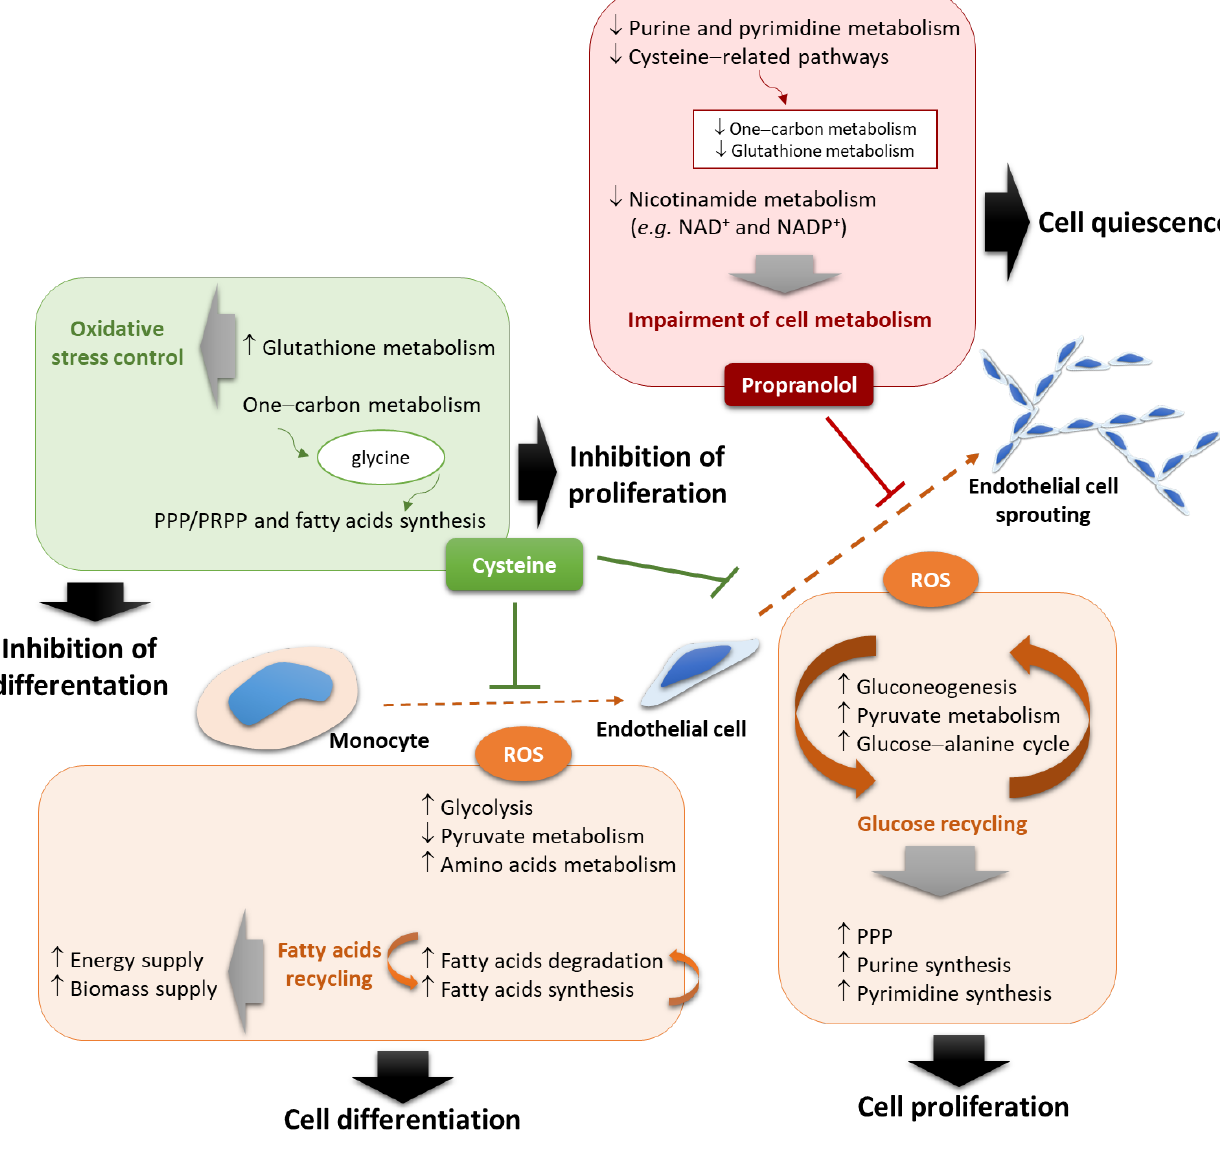
Figure 7. Metabolic profiling is an indicative of cell biological processes. ROS are a main stimulus for monocyte-to-endothelial-cell differentiation and endothelial cell proliferation. In this differentiation process, monocytes present increased glycolysis and amino acid metabolism with decreased pyruvate metabolism and fatty acid recycling. The ROS-dependent activation of proliferation is accompanied by a glucose-recycling metabolic adjustment, which will favor glucose-dependent pathways as the pentose phosphate pathway (PPP) and purine and pyrimidine syntheses. Cysteine inhibits monocyte-to-endothelial-cell differentiation and endothelial cell proliferation, with a concomitant upregulation of glutathione metabolism, and activates the glycine shuttle from one-carbon me- tabolism into the PPP/phosphoribosyl diphosphate pathway (PRPP) and fatty acid synthesis. Pro- pranolol inhibits endothelial cell proliferation [18], and this accounts for a decrease in metabolic efforts, since a reversion of the metabolic pathways enhanced upon the stimulation of cell prolifer- ation resembles a metabolic impairment consistent with cell quiescence. − decrease; − increase Metabolic profiling can be a powerful tool to follow the differentiation of endothelial progenitor cells, as monocytes, and to determine the formation of new vascular networks supporting in vitro tissue growth and viability in a perspective of regenerative medicine. This study is a step forward into a better knowledge of the metabolic adaptation needed for endothelial cell differentiation and activation/proliferation. Besides the metabolic shift